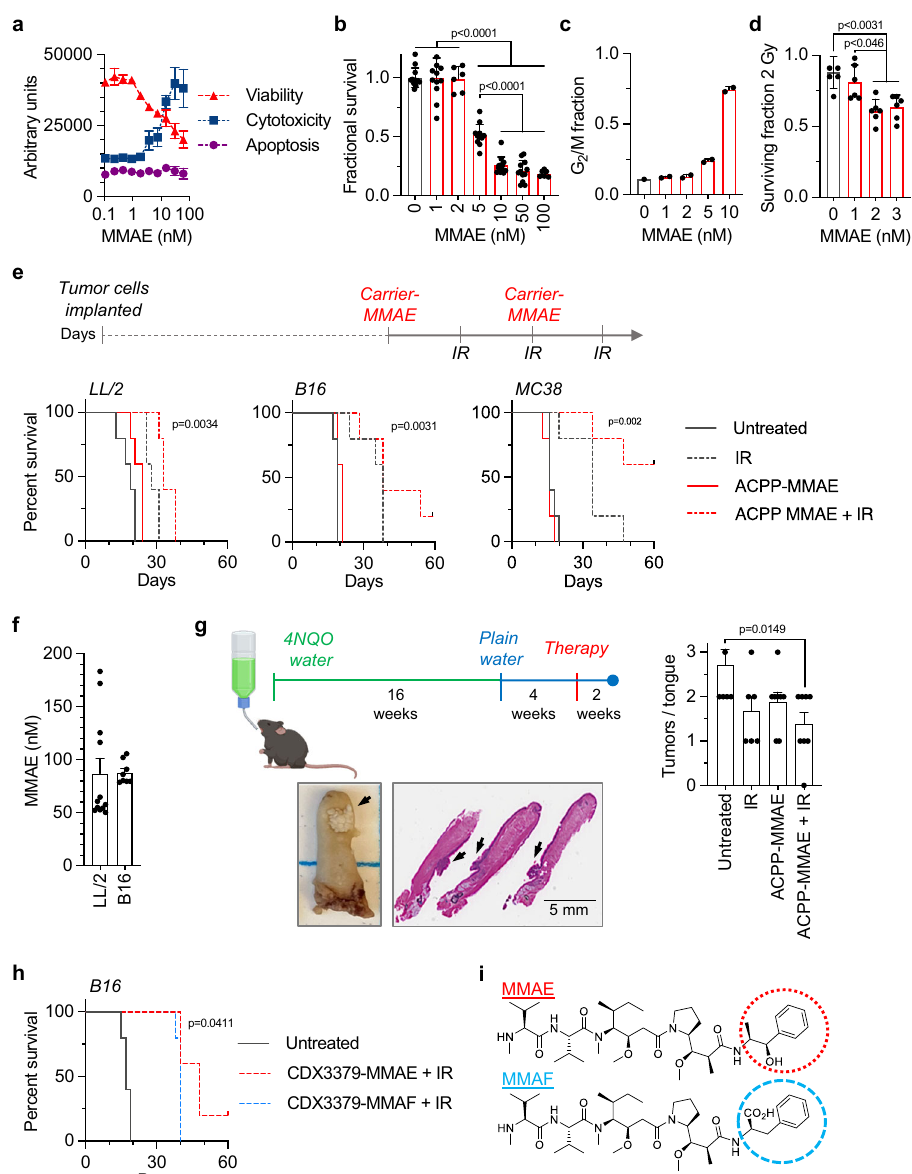
Fig. 3 MMAE radiosensitizes syngeneic murine tumors. a B16 cells treated with MMAE and analyzed by ApoTox-Glo Triplex Assay. Data plotted as mean± SD, n = 3. b For clonogenic survival, B16 cells treated with MMAE, colony number normalized and plotted as mean ±SEM, n = 11 (0, 1, 5 10, 50nM), n = 5 (2, 100 nM). Statistical signi fi cances calculated using one-way ANOVA with Tukey ’ s multiple comparisons test. c Cell cycle analysis of MMAE-treated B16 cells. Data plotted as mean± SD, n = 2. d Clonogenic survival of B16 cells treated with MMAE and 2Gy. Data plotted as mean ± SEM, n = 6. Statistical signi fi cances calculated using one-way ANOVA with Sidak ’ s multiple comparisons test. e Treatment scheduling MMAE + IR in subcutaneous tumors. Tumor cells implanted on day 0. Treatment started on day 3 for LL/2 and B16 and day 6 for MC38 tumors. 10nmoles ACPP-MMAE injected for 2 doses. IR given on 3 consecutive days, 5Gy/day (LL/2, B16) and 3 Gy/day (MC38). Mouse survival plotted and statistical signi fi cances (ACPP-MMAE + IR vs. ACPP-MMAE) calculated using Log-rank (Mantel – Cox) test, n = 5. f Tumor-bearing mice injected with 10nmoles of ACPP-MMAE, n = 12 (LL/2) n = 8 (B16). Tumors harvested, drug concentration scatter plot with mean± SEM. g 4NQO carcinogen-induced tongue model. At week 20 after 4NQO exposure, mice injected with 10nmoles ACPP-MMAE × 2 doses. Whole tongue IR given as 5 Gy× 2. Tongues resected at week 22, H&E stained, and tumors quanti fi ed. Representative whole and sectioned untreated tongues (tumors indicated by black arrows). Mean tumors/tongue± SEM plotted, n = 7 (untreated), n = 6 (IR), n = 8 (ACPP-MMAE, ACPP-MMAE + IR). Statistical signi fi cances calculated using one-way ANOVA with Tukey ’ s multiple comparisons test. h Mice implanted with B16 tumor cells on day 0 and treated as in Fig. 3e except for 2.5 nmole dose of ADC. Mouse survival plotted and statistical signi fi cance (CDX3379-MMAE + IR vs. CDX3379-MMAF + IR) calculated using Log-rank (Mantel – Cox) test, n = 5. i Chemical structure of auristatins with moieties altering cell permeability circled. Results in ( a , c ) representative of 2 independent experiments. Source data provided in Source Data fi tumors respectively. Quantitating CD4 + , CD8 + , and NK cells cell suspensions were analyzed by fl ow cytometry (Fig. 4a, Sup- within tumors demonstrated an increase of these immune cell plementary Fig. 10a). As a percentage of live cells, CD45 + cells populations when MMAE and IR were given together (Fig. 4a, were 5.2%, 8.6%, 26.3%, and 69.1% for vehicle injected (water) Supplementary Fig. 10b). In particular, a striking relative and control, ACPP-MMAE, IR and ACPP-MMAE + IR-treated